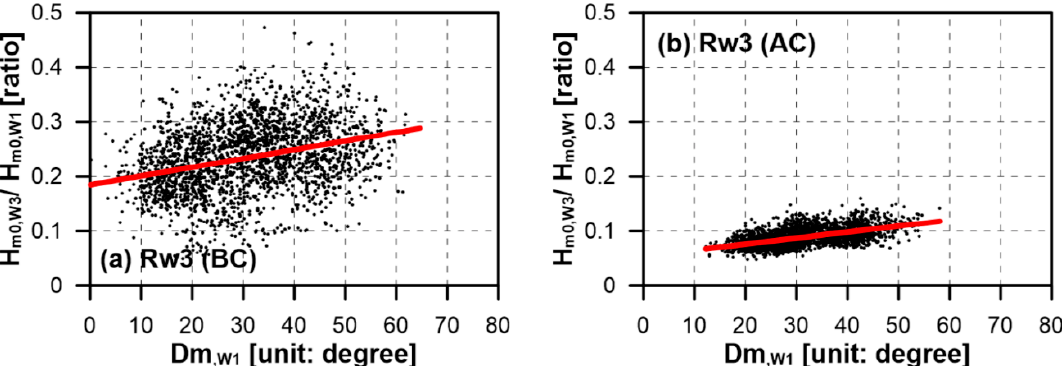
Figure 20. Comparison of the scatter plots of R W 3 (the wave height reduction rate based on obser- vation data) in terms of D p in W1, ( a ) BC and ( b ) AC. The red line in each panel shows the linear regression calculated for each data set. The lower R W 3 magnitude in AC indicates that the wave energy was effectively reduced inside the port, confirming the effect of the detached breakwater in securing the tranquility of the port.